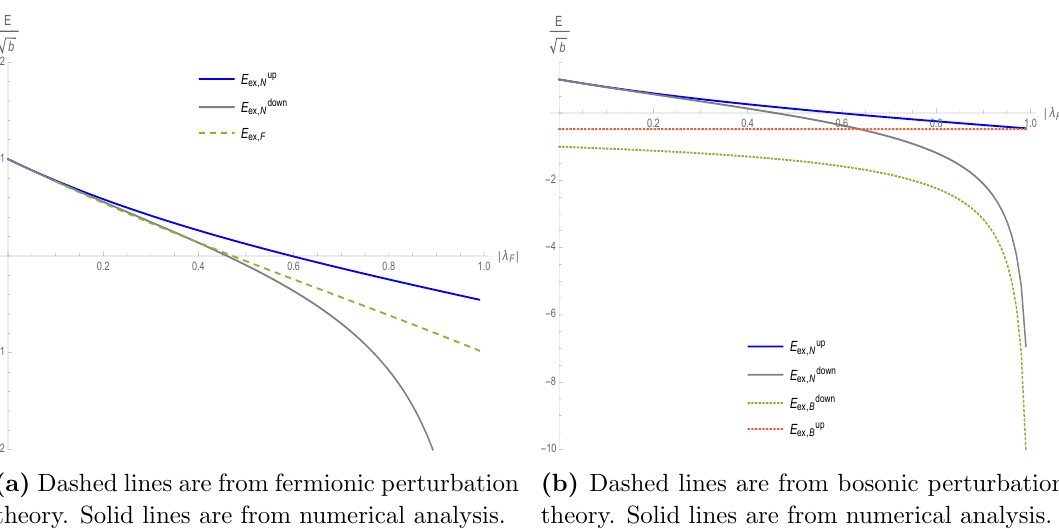
(b) Dashed lines are from bosonic perturbation theory. Solid lines are from numerical analysis.